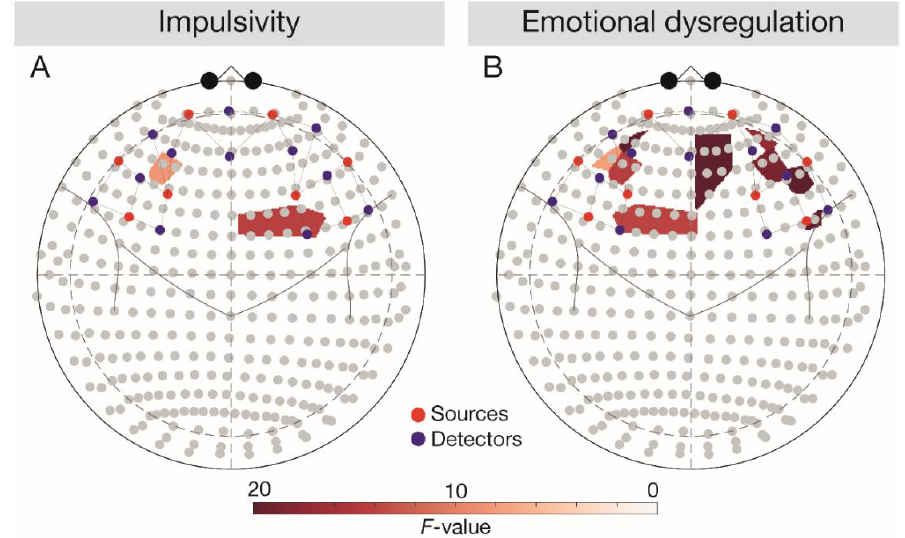
Figure 2. Main effects of impulsivity and emotional dysregulation depicted in 10–20 system. Results were analysed across tasks. Red dots depict sources, blue dots depict detectors. ( A ) Depicting the main effect of DERS score, ( B ) depicting the main effect of BIS score. BIS, Behavioural Inhibition System; DERS, Difficulties in Emotion Regulation Scale.